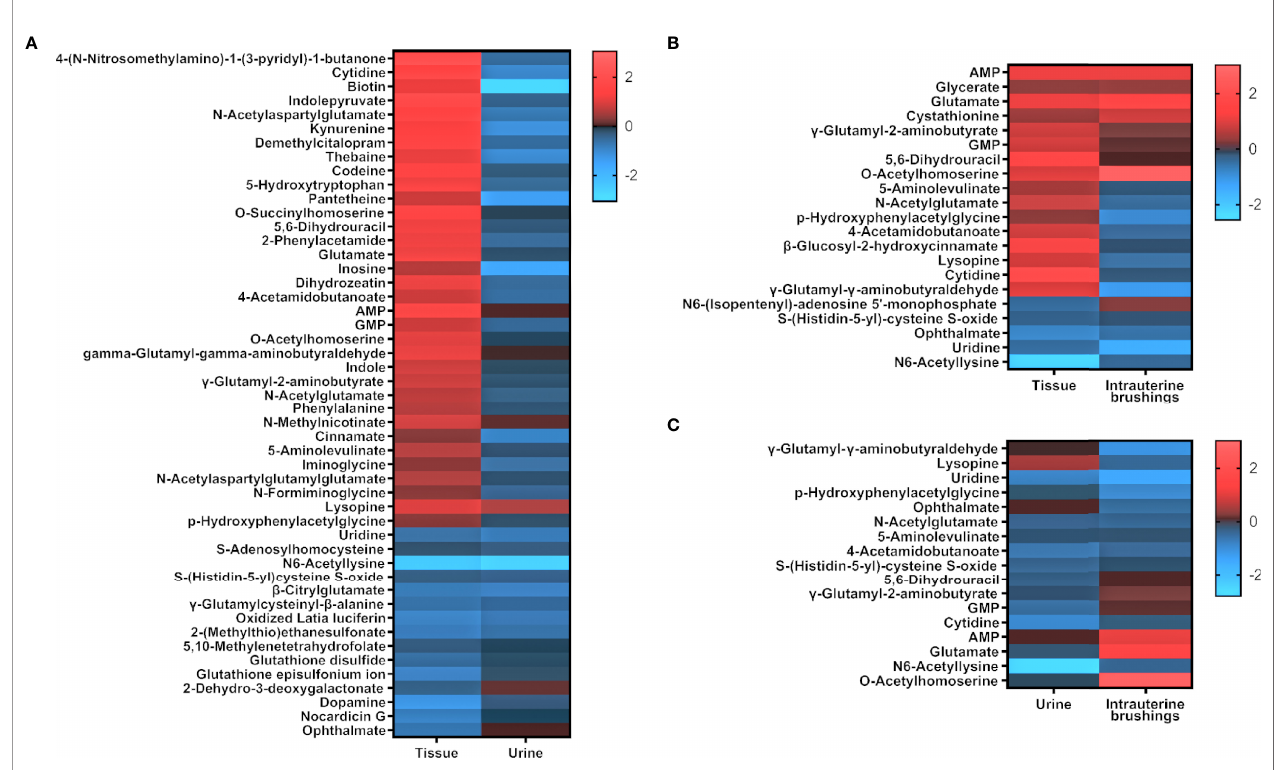
FIGURE 6 | The regulation of signi fi cant metabolites identi fi ed from tissue samples compared to those in urine and intrauterine brushing samples. Heatmaps show the comparison of log 2 (FC) values (EC patients to controls) between (A) tissue and urine, (B) tissue and intrauterine brushings, and (C) urine and intrauterine brushings. Red indicates upregulation; blue indicates downregulation; dark indicates no